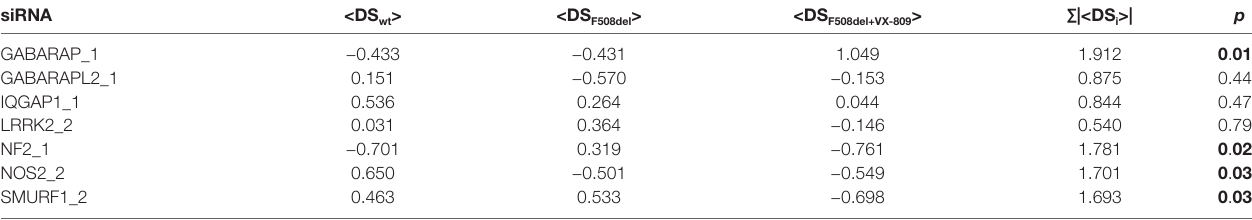
DS i (i corresponding to wt-, F508del-, or F508del-CFTR+ VX-809) informs on the siRNA capacity to influence the traffic efficiency of a particular CFTR type. The sum of the three DS mean absolute values (∑ | <DS i >| ) constitutes a global measure of the siRNA effect. Statistical significance (p) of these effects were calculated using a random permutation test (see Materials and Methods for details). Values highlighted in bold when